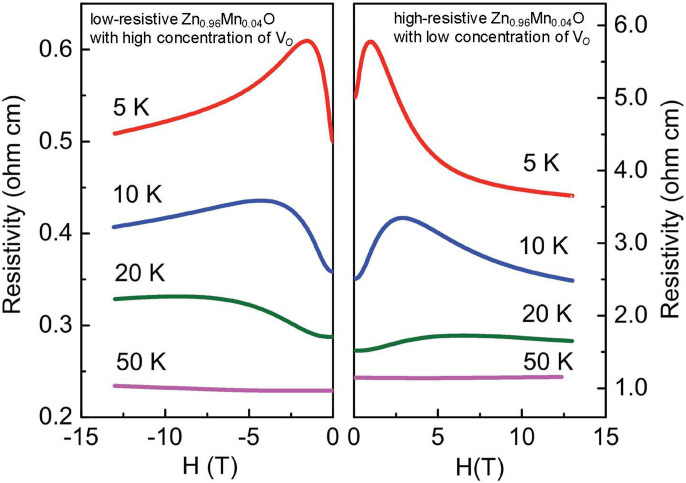
Resistivity as a function of temperature and magnetic field for Zn1−xMnxO with x = 0.04 and different concentrations of VO's.